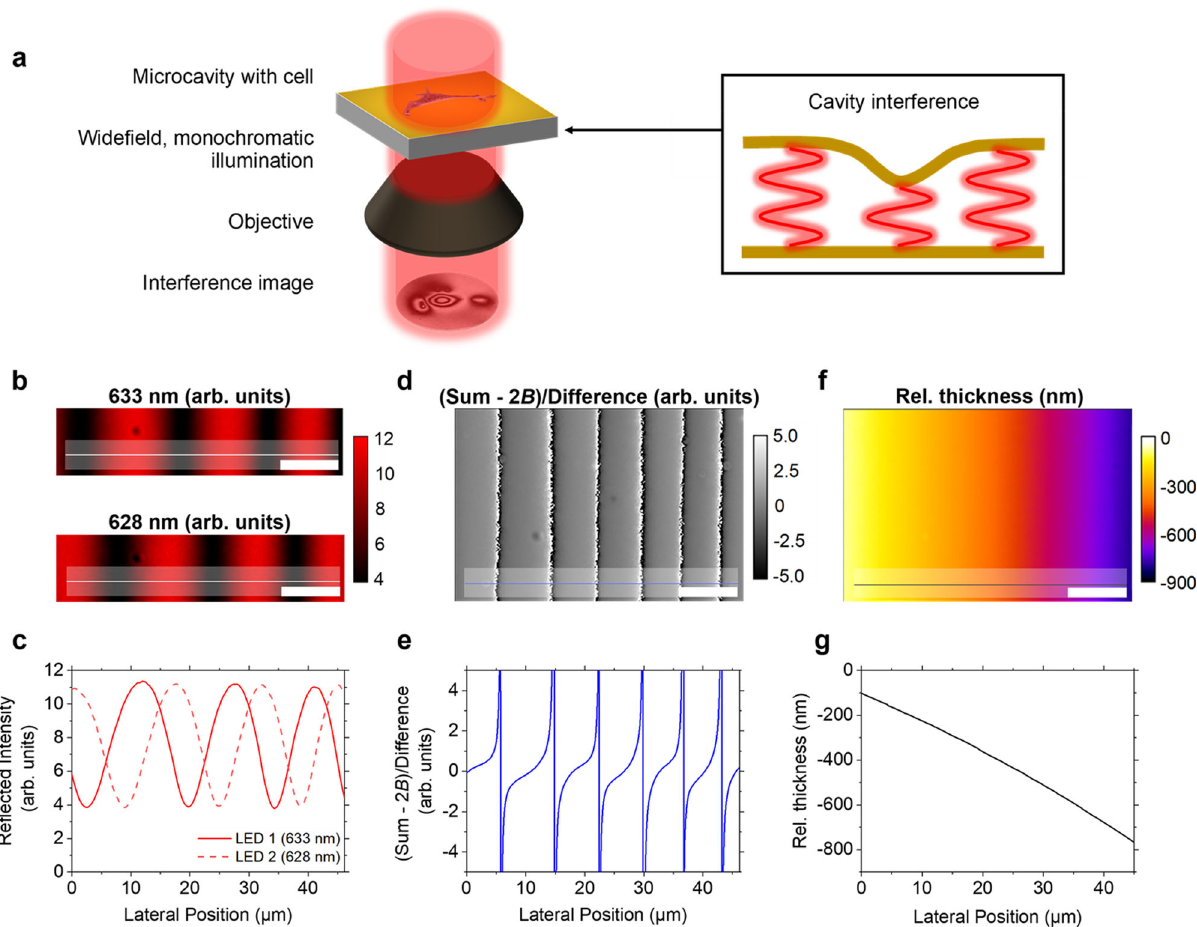
Fig. 1 Principle of wavelength-alternating resonant pressure (WARP) microscopy. a Schematic of elastic microcavity chip with a cell cultured on the top mirror surface (not to scale). As the cell exerts force, the cavity thickness changes locally, thus creating an interference fringe pattern when imaging the re fl ection from the cavity. b Interference fringes formed along a region of continuously varying cavity thickness for two different illumination wavelengths (633 nm and 628 nm). Colour bar in arbitrary units. c Intensity pro fi les along lines in b showing the phase difference between the two wavelengths. d Division image created by dividing the background-subtracted sum of the images in b by the difference of the images in b . Greyscale in arbitrary units. e Pro fi le along the line in d , illustrating the presence of directional information in this new image that is absent from the original images in b . f Ground truth of relative cavity thickness for region shown in d , as obtained by wavelength-scanning ERISM. g Pro fi le along line in f . A comparison with the pro fi le in e yields a lookup table for relative thickness changes between fringes. Combined with automated fringe counting, this table links the numerical value at each point in a division image to the local displacement of the cavity top mirror. Scale bars, 10 µ image resulting from the division can be translated into a map of local relative thickness using a combination of (i) automated fringe counting, considering that the thickness difference between adjacent fringes is (cid:4) 113 nm, and (ii) a lookup table that converts the numerical value of Eq. (5) into a thickness change for the regions between fringe boundaries. This is done by opening both the division and difference images in a software script and scanning across the same line of pixels in parallel. Zero-crossing points in the difference image are identi fi ed as fringe transitions and, therefore, as transitions between adjacent fringe modes. The corresponding sign transition in the division image (positive-to- negative or negative-to-positive) determines the direction of displacement between fringes. For each microcavity with a speci fi c combination of top and bottom mirror re fl ectance, there is a combination of uniquely shaped cotangent image modes, Mode 1 and Mode 2 (see Supplementary Note 2 on the algorithm for more details). Whether a pixel in the division image corresponds to Mode 1 or Mode 2 is established by considering the sign of the same pixel in the difference image. Establishing fringe transitions provides displacement accuracy to within a